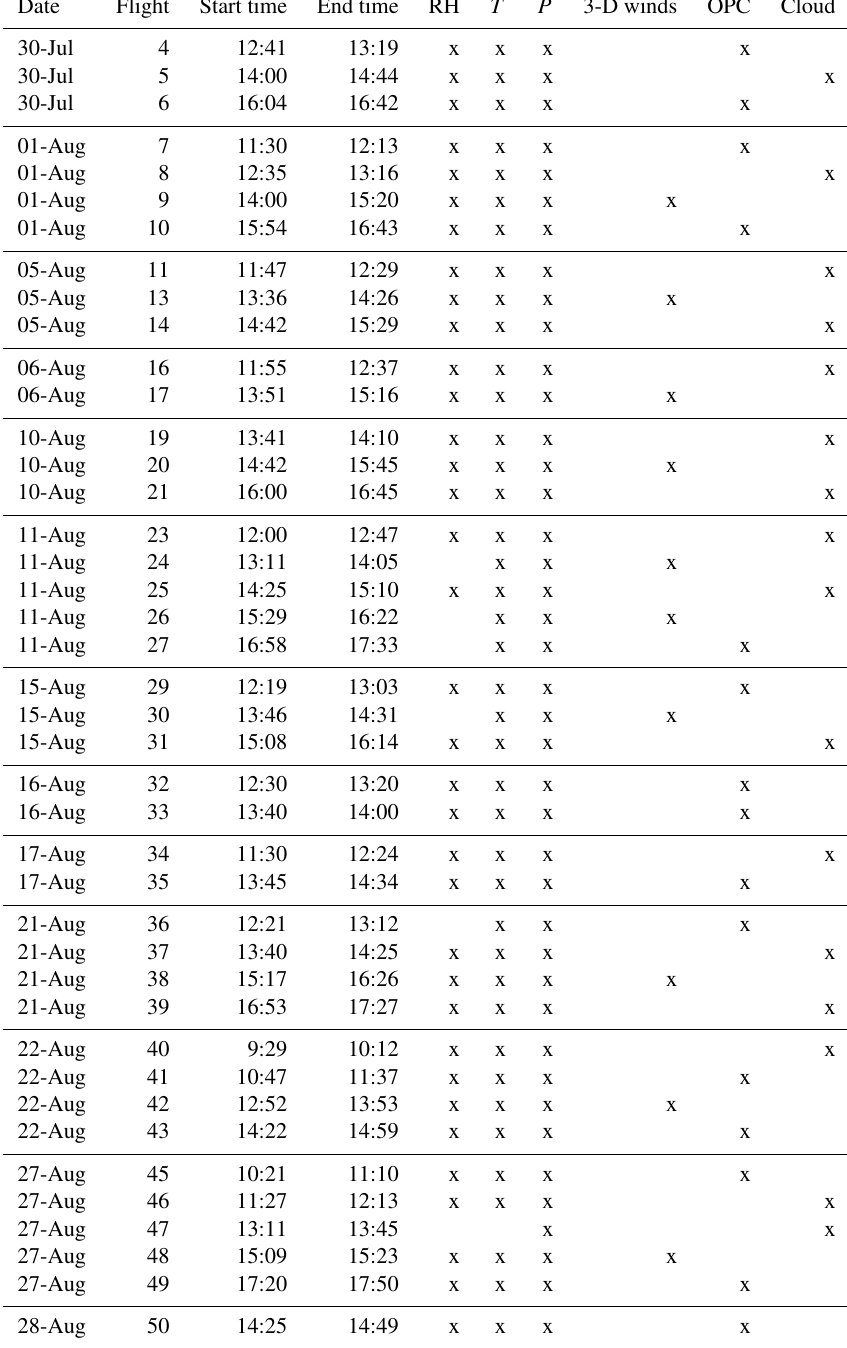
Table 1. UAV research flights conducted at Mace Head, Ireland, and measured parameters in 2015. Flight start and end times are in UTC. NASA’s Suomi National Polar-orbiting Partnership satellite overpasses occurred at approximately 13:00UTC. Measurements include relative humidity (RH), temperature ( T ), pressure ( P ), three-dimensional wind vectors (3-D winds), optical particle counter (OPC) and cloud sensor measurements of cloud droplet